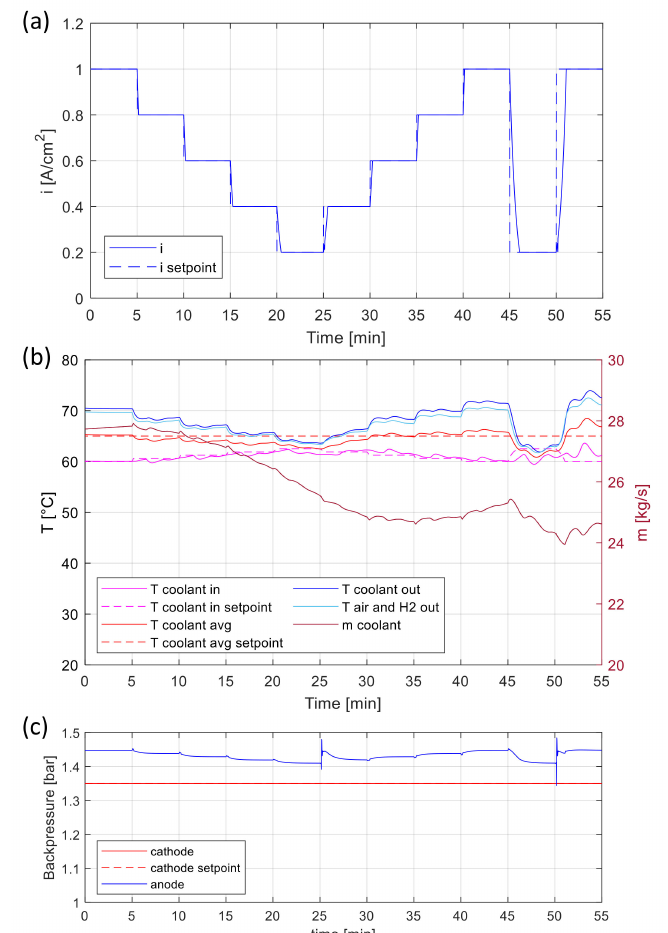
Figure 4. Simulation of load-following operation: time profile of ( a ) simulated current density vs setpoint; ( b ) coolant temperature at stack inlet vs setpoint, coolant average temperature over the stack vs setpoint, coolant temperature at stack outlet, air and hydrogen temperature at stack outlet, coolant flowrate; ( c ) cathode backpressure vs setpoint, and anode